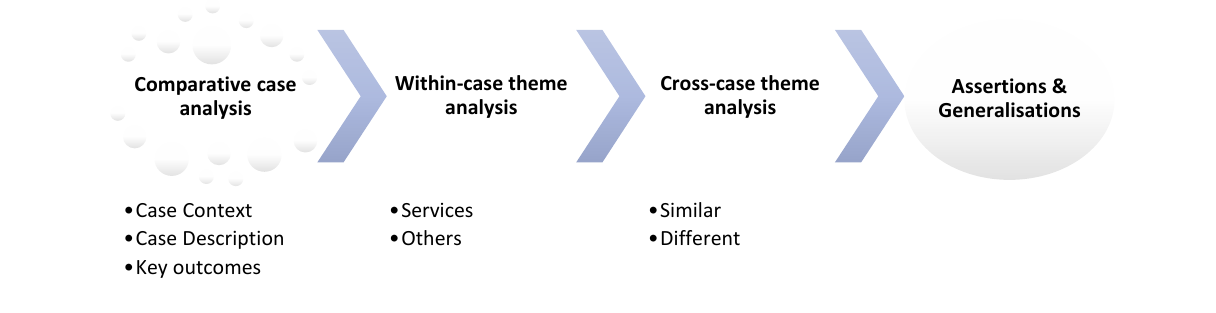
Comparative case analysis